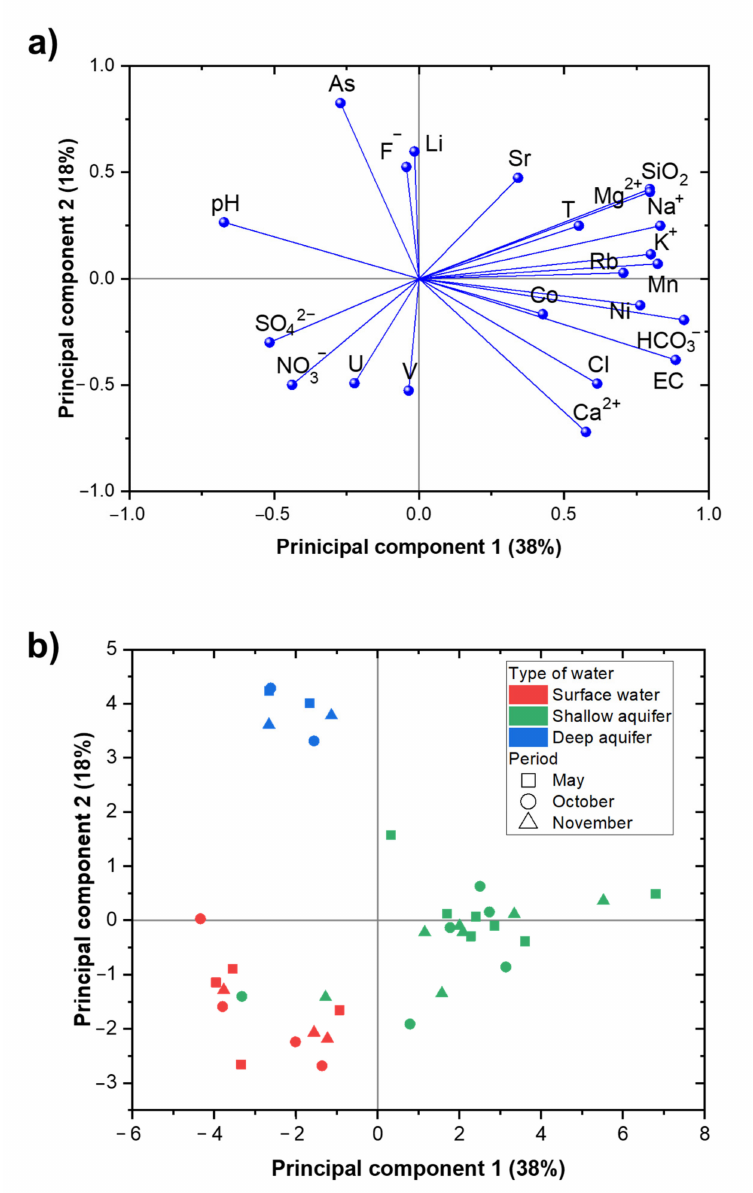
Figure 4. ( a ) PCA variable loadings and ( b ) score plot of principal component 1 (explaining 38% of the total variance) vs. component 2 (explaining 18% of the total variance) for all the analyzed